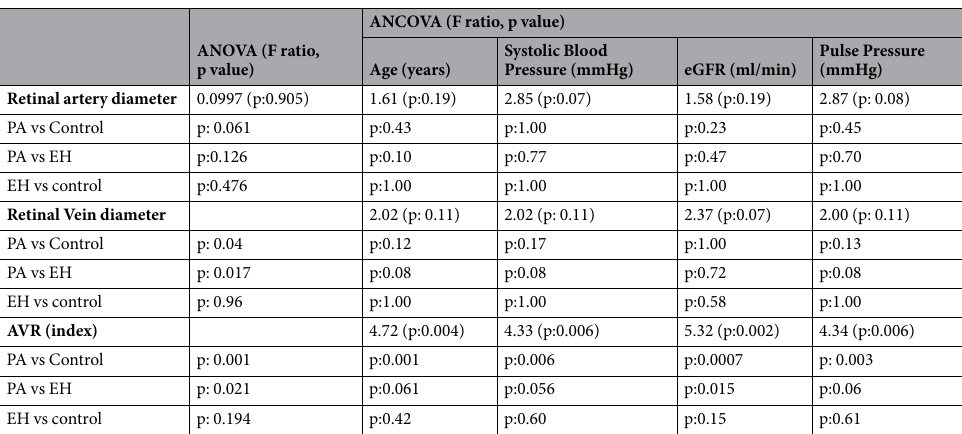
Table 3. Retinal artery diameter, retinal vein diameter and AVR in Essential Hypertension and Primary Aldosteronism: analysis of variance and influence of the covariates: age, systolic blood pressure, eGFR